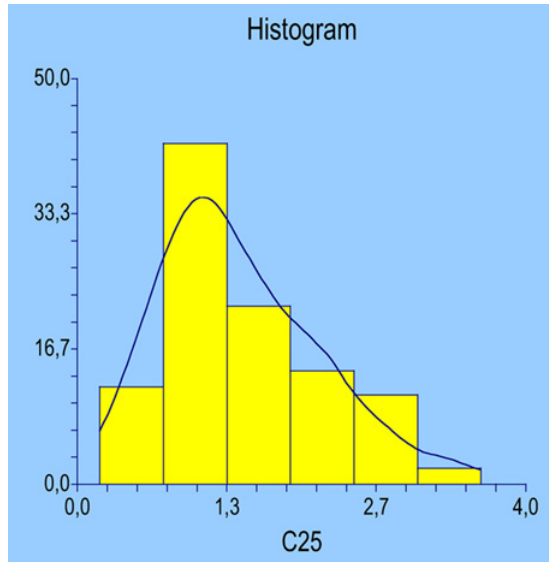
FIGURE 4. Distribution of size (maximum diameter, in cm) in